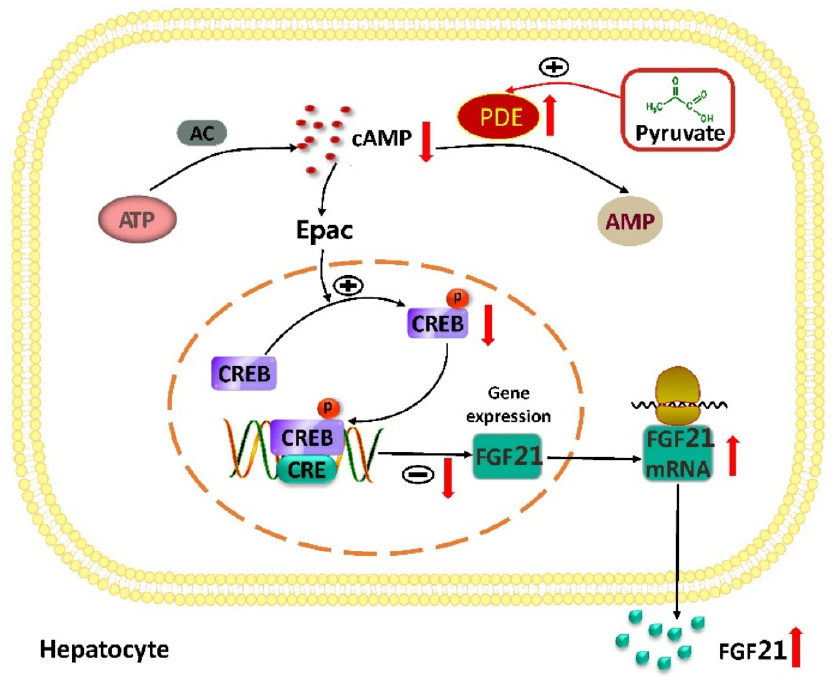
Figure 7. The diagram of pyruvate-stimulated FGF21 expression in hepatocytes. cAMP–Epac–CREB signaling inhibits FGF21 expression in human and mouse hepatocytes. Pyruvate activates PDEs to reduce cAMP levels and then inhibits cAMP–Epac–CREB signaling to upregulate FGF21 expression in